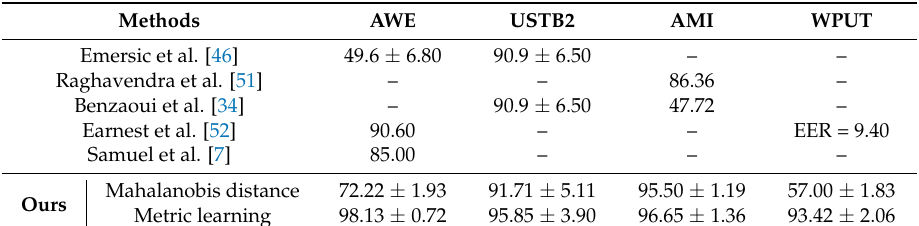
Table 1. Comparison on recognition rate (%) for the AWE, USTB2, AMI, and WPUT